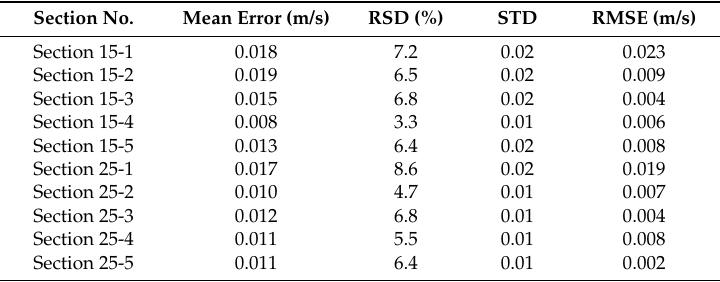
Table 5. Error analysis results. RSD: relative average deviation; STD: standard deviation; RMSE: root-mean-square error.